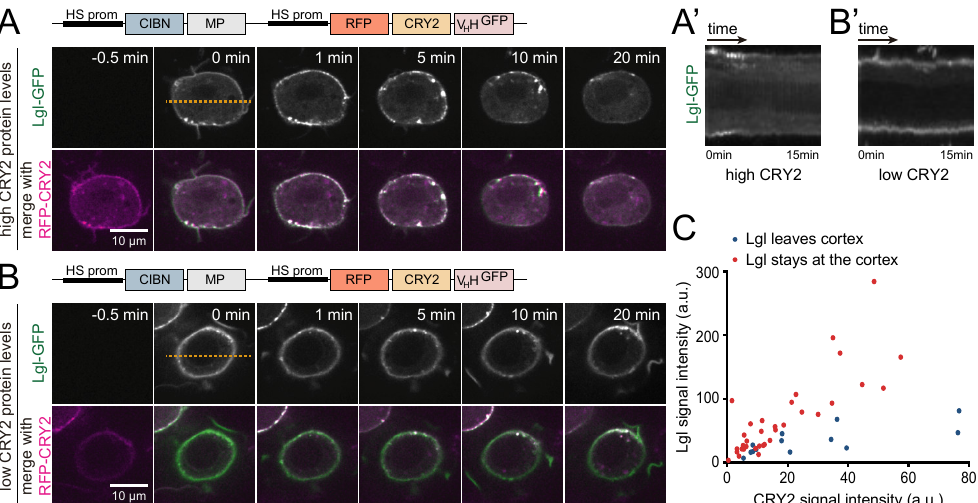
Figure 6. High levels of LARIAT delocalize membrane-associated Lgl-GFP. ( A , B ) Representative single z-sections and ( A’ , B’ ) respective kymographs of Drosophila S2 cells transiently transfected with Lgl-GFP, CIBN-MP, and RFP-CRY2-V H H expressing ( A , A’ ) higher or ( B , B’ ) lower levels of CRY2 relative to Lgl. ( C ) Dispersion plot for average Lgl-GFP and RFP-CRY2-V H H signal intensity in cells in which Lgl left (blue) or remained in (red) the cortex after clustering. Each dot represents a single cell.